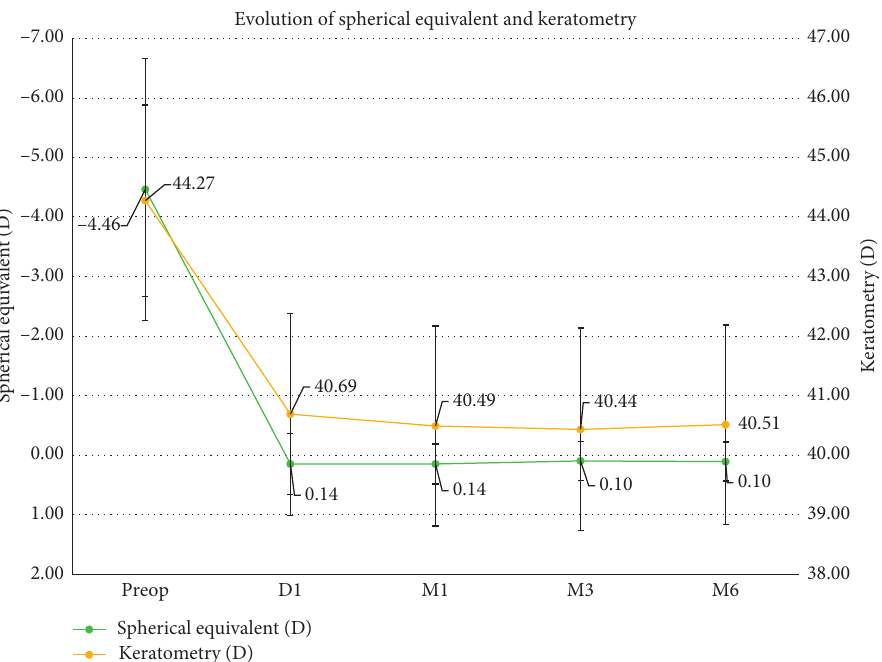
Figure 10: Stability of keratometry and spherical equivalent refraction after LASIK between 1 day and 6 months. 020406080100